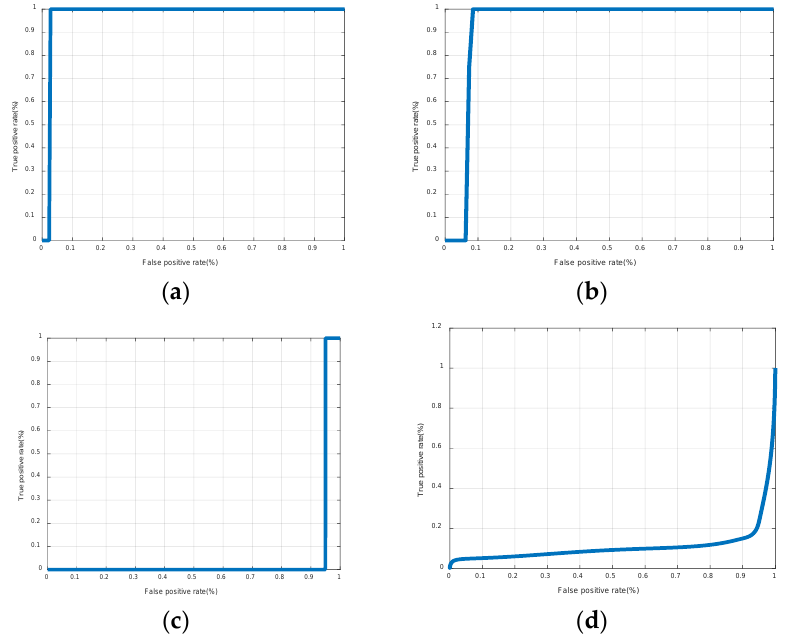
Figure 20. ROC curves for cancellable face recognition frameworks (for FERET dataset) for ( a ) CFR1, ( b ) CFR2, ( c ) homomorphic transform followed by salting and ( d ) homomorphic transform followed by random kernel convolution.